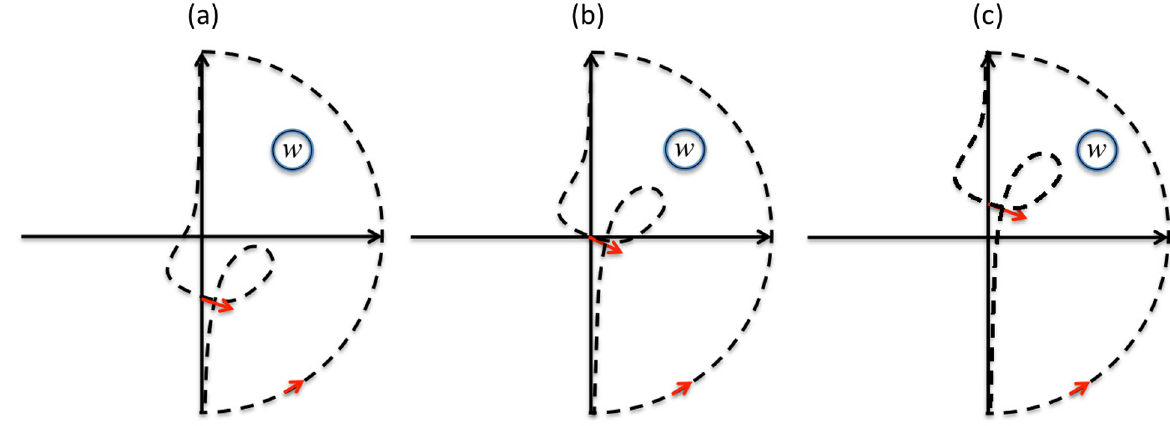
FIG. 4. (a) Map of the contour C corresponding to one growing eigenmode, W ¼ 1 . (b), (c) Map of the contour C corresponding to the absence of the growing